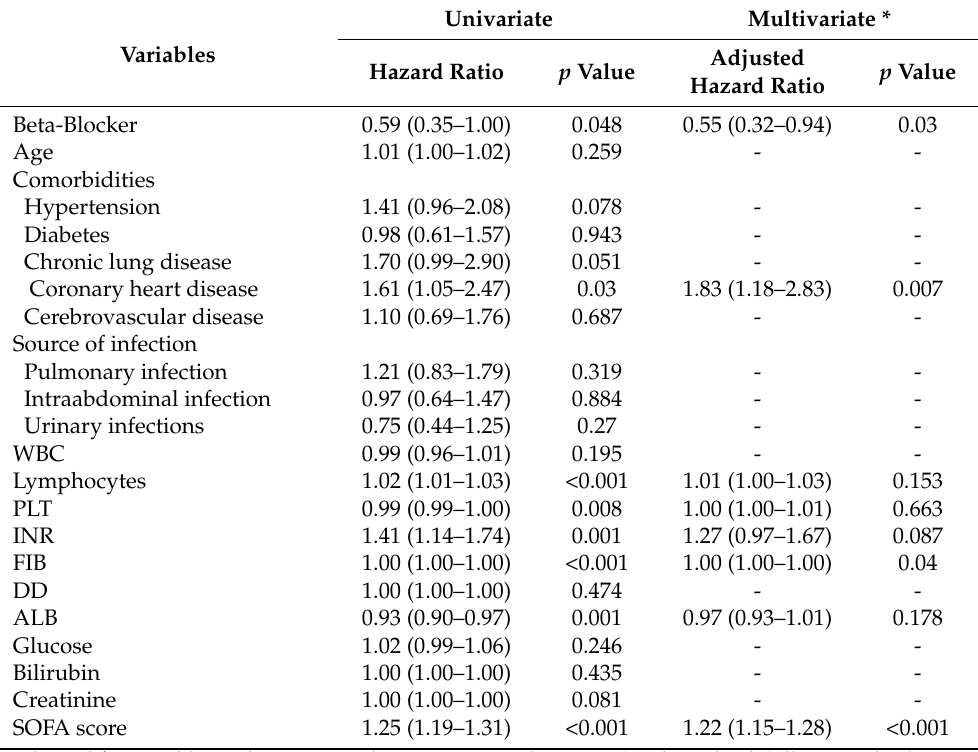
Table 4. Cox proportional hazard analysis of risk for 28-day mortality in patients with sepsis- associated coagulopathy in univariate and multivariate